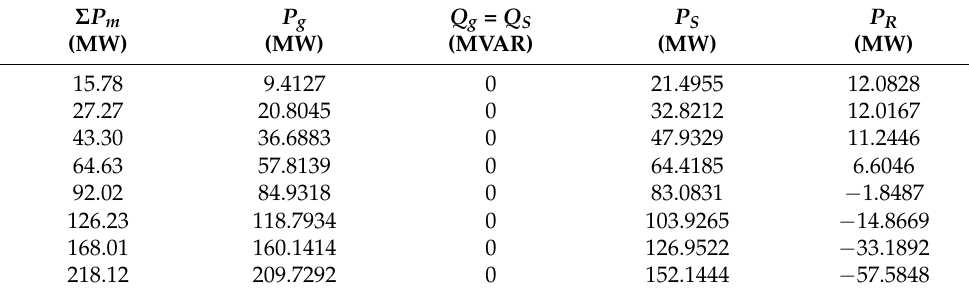
Table 7. DFIG power flow (PF = 1.0).